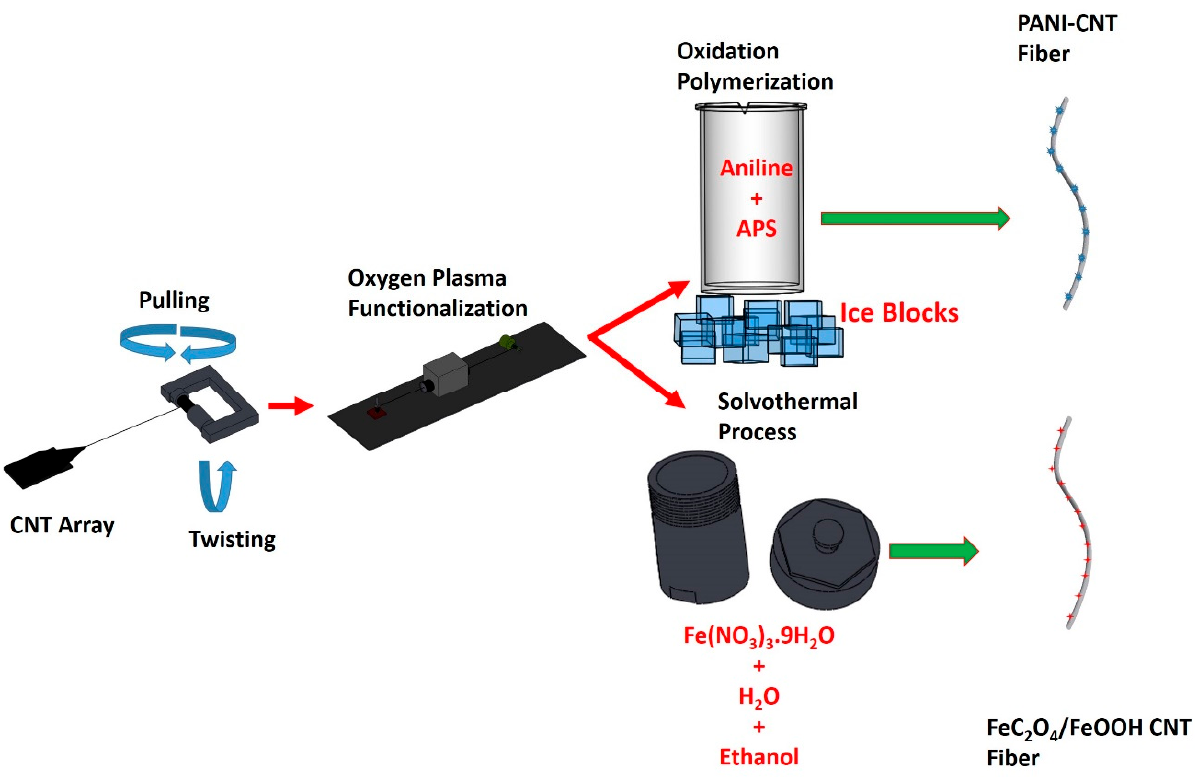
Figure 1 . Fiber fabrication process steps. Figure 1. Fiber fabrication process